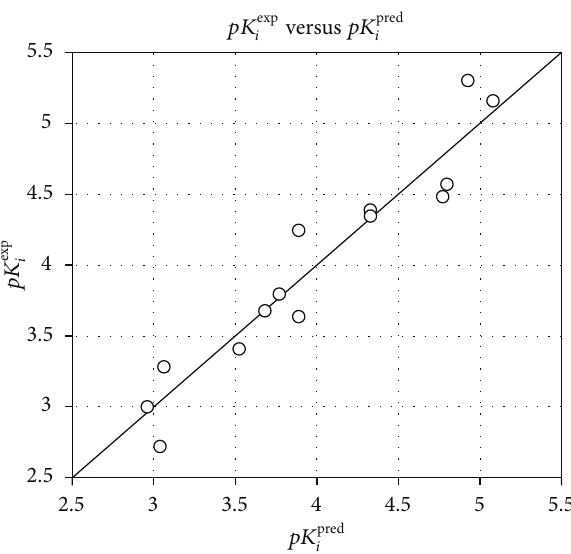
Figure 7: Plot of the correlation equation between pharmacophore (PH4) predicted and experimental inhibitory activity of the training set